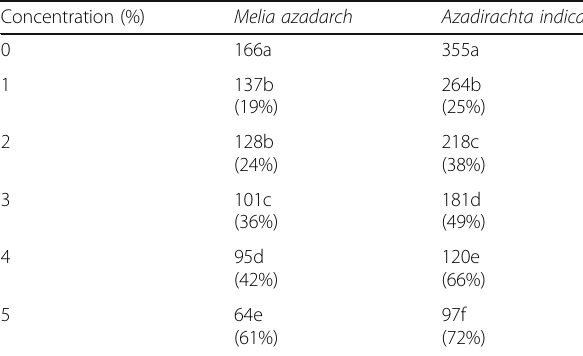
Table 1 Effect of different concentrations of Trichoderma species filtrate on biomass (g) of Macrophomina phaseolina Concentrations (%)